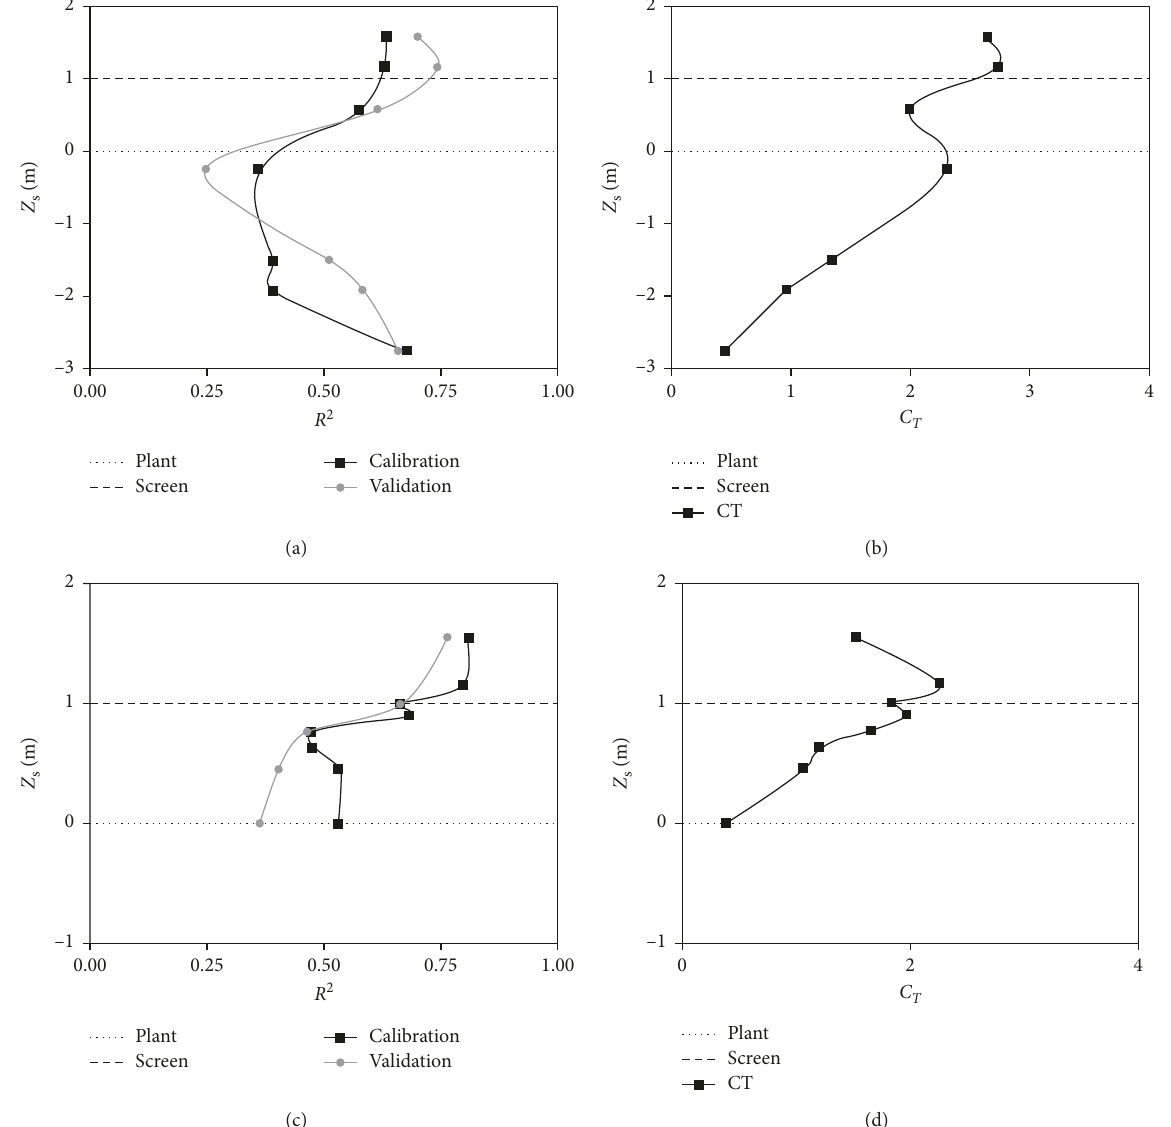
Figure 6: Vertical distributions of R 2 during calibration (black line) and validation (grey line) in the two campaigns, S1 (a) and S2 (c), respectively. (b) and (d) are the corresponding distributions of C T for the validation conditions. In S2, calibration and validation were against reference measurements of H EC above the screen. Z S